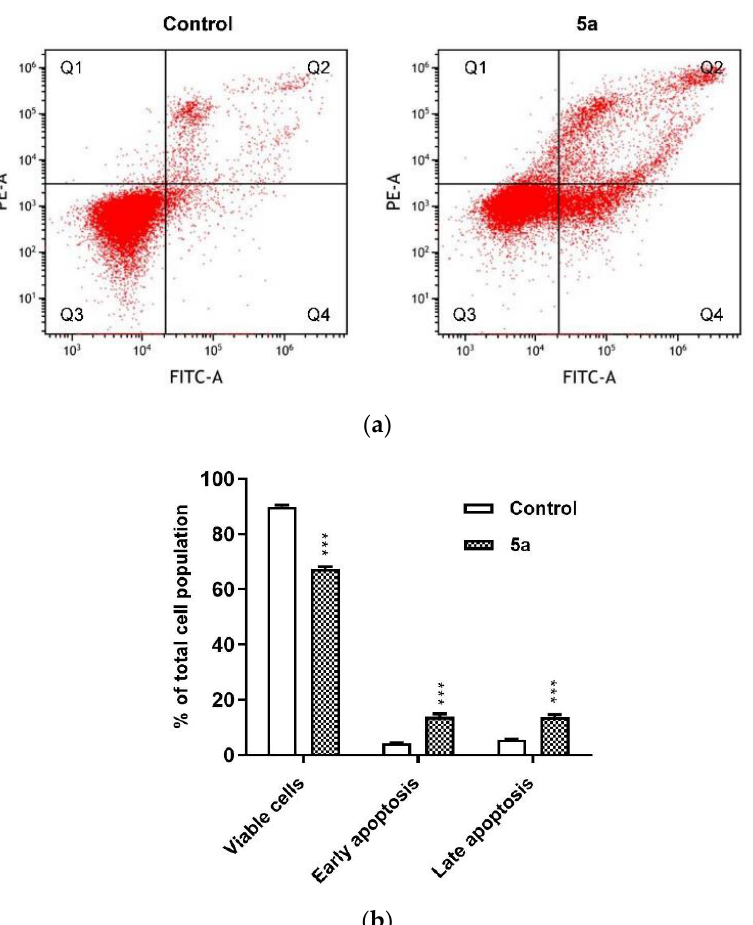
Figure 5. Induction of apoptosis in HL-60 cells treated with 5a (1.8 µM) for 24 h: ( a ) Representative scattered blots of flow cytometry analysis of apoptosis by double-staining with FITC-Annexin-V and PI. The percentage of viable cells is shown in quadrant Q3. Quadrant Q4 indicates the percentage of early apoptotic cells (Annexin V-positive cells), whereas quadrant Q2 shows the percentage of late apoptotic/death cells (Annexin V-and PI-positive cells). ( b ) Quantitative analysis of apoptotic cell death by Annexin V and PI assay. Data are presented as mean ±SEM of three independent experiments. Statistical significance was assessed using Student’s t test. *** p < 0.001 vs. control.